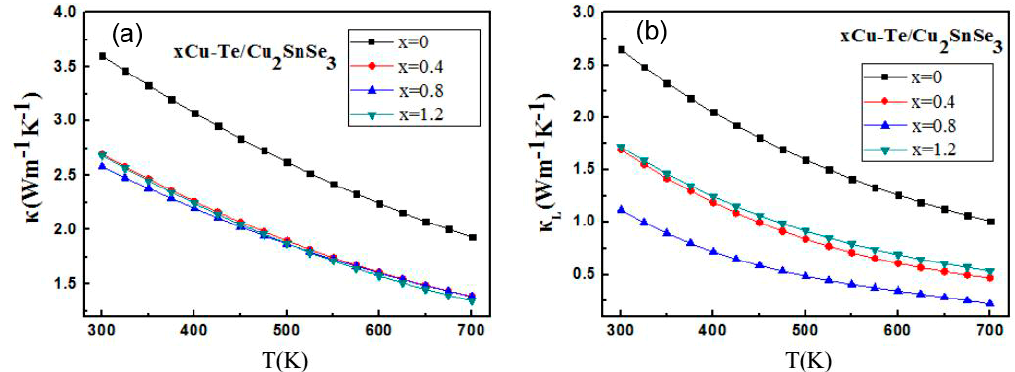
Figure 9. The temperature dependence of thermal conductivity κ ( a ) and lattice thermal conductivity κ L ( b ) for Cu–Te/Cu 2 SnSe 3 composites. κ / Cu L ( b ) for Cu–Te 2 SnSe 3